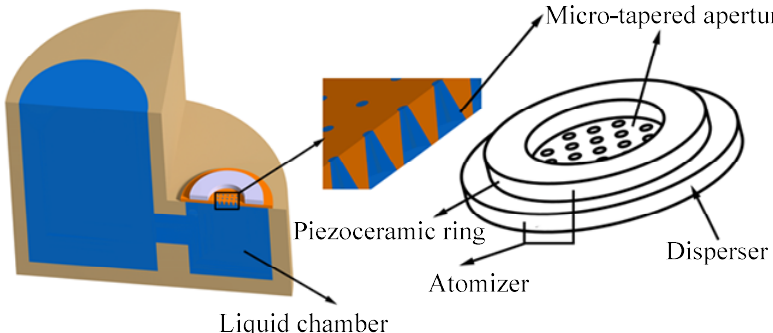
Figure 1. Illustration of the atomizer structure with a piezoceramic vibrating mesh atomizer [31].